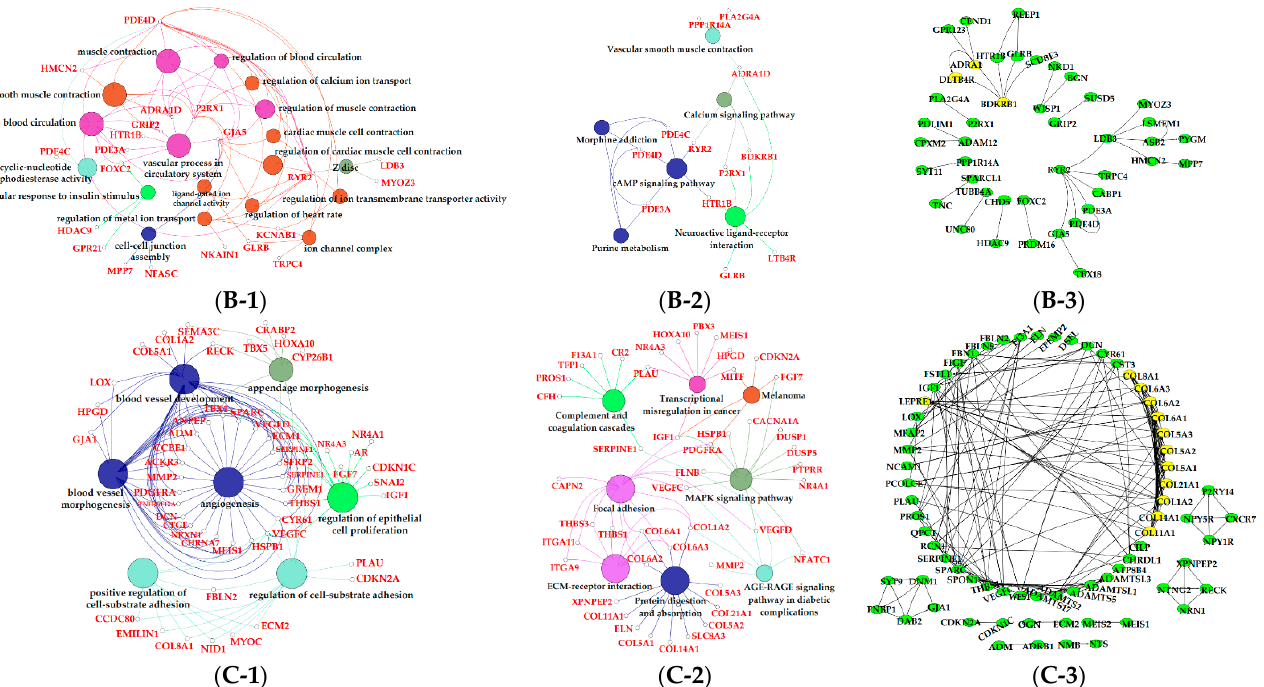
Figure 6. Functional analysis of genes in magenta, green and turquoise modules. Gene ontology (GO) analysis of genes in magenta ( A-1 ), green ( B-1 ) and turquoise ( C-1 ) modules. Kyoto Encyclopedia of Genes and Genomes (KEGG) pathway analysis of genes in magenta ( A-2 ), green ( B-2 ) and turquoise ( C-2 ) modules. The significant GO terms and KEGG pathways were visualized using Cytoscape software based on network analysis of ClueGO/CluePedia inferred from MCODE clusters. The size of nodes indicated the p -value. The color of nodes represented the functional group that they belonged to. The names of important pathways were in black bold characters. The protein–protein interaction (PPI) networks showed the interactions of genes in the magenta ( A-3 ), green ( B-3 ) and turquoise ( C-3 ) modules, respectively. Each node represented a gene and the yellow nodes expressed the key genes in each module.